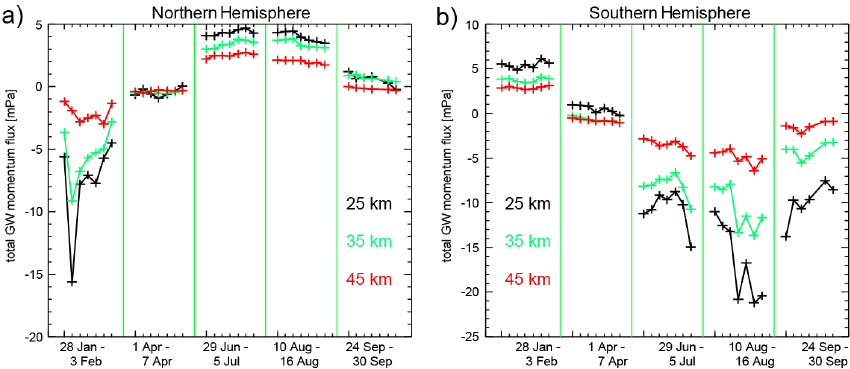
Figure 10. Zonal gravity wave momentum flux calculated according to Eq. (5) from the full-resolution model winds and integrated over latitudes 0 ◦ to 90 ◦ N for the Northern Hemisphere is shown in (a) and integrated over latitudes 0 ◦ to 90 ◦ S for the Southern Hemisphere is shown in (b) . Color indicates altitudes of 25km (black), 35km (green) and 45km (red). The individual 7-day periods are separated by vertical green